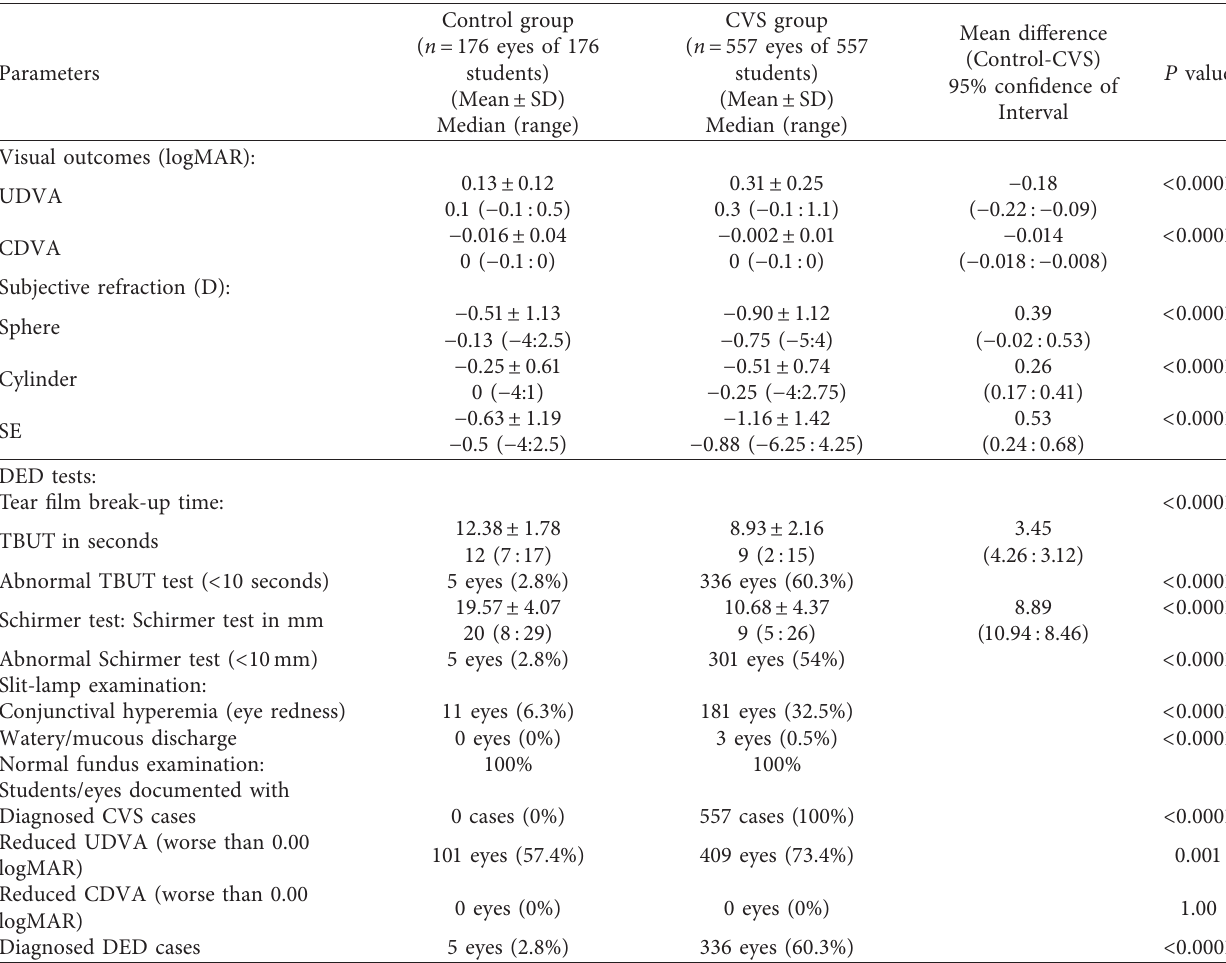
Table 9: Differences between the control and CVS